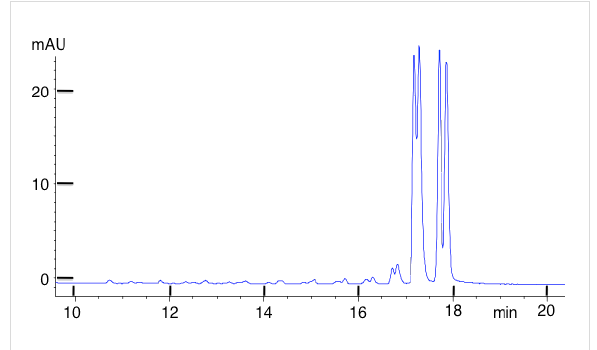
Figure 3: HPLC analysis of deoxyoligos A 10 XA 9 with X = A, G, C, T. An equimolar mixture of four 20-mers differing only by one